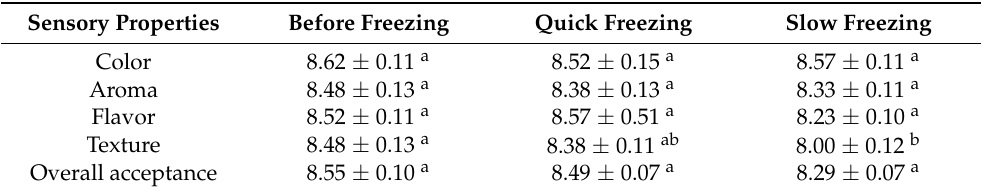
Table 6. Sensory properties of reheated braised mackerel with radish before freezing and after slow and quick